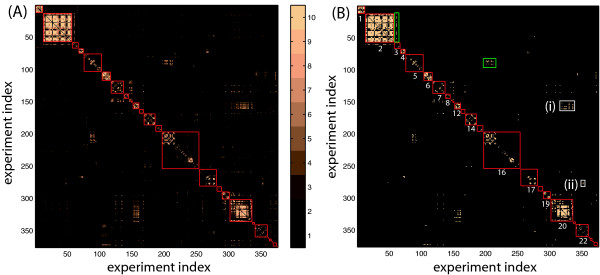
Correlated experiments in the compendium. Heatmaps of (A) -log(p-value) for experiment correlation coefficients (colorbar) and (B) significantly correlated experiments at FDR ≤ 0.1 (shown in gold). Red boxes delineate projects, with project index labeled below the boxes (where space permitted). Green and white boxes are referenced within the text.